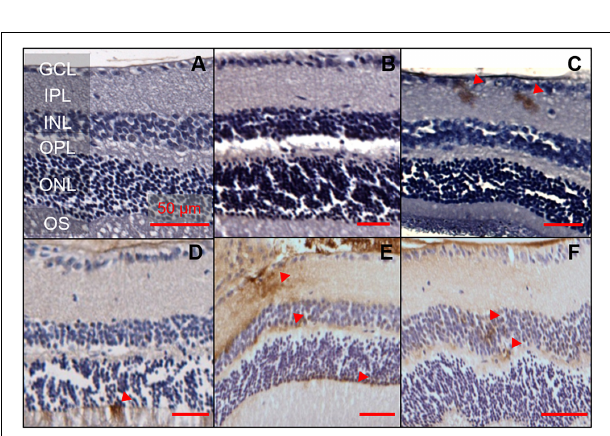
FIGURE 2 | A β was detectable in 5xFAD mice retinae at various ages. 1E8 labeled serial sections counterstained with haematoxylin showed A β immunoreactivity in the inner and outer retina of 5xFAD mice. 1E8 staining absent in (A) a 6-month-old WT mouse retina and (B) a negative control in a 6-month-old 5xFAD retina. 1E8 staining present in (C) a 6-month-old 5xFAD retina (D) a 12-month-old 5xFAD retina and (E,F) a 17-month-old 5xFAD retina. Positive A β staining was seen in the ganglion cell layer, inner plexiform layer, the inner and outer nuclear layers as marked by red arrows. Images feature tangential cuts to the retina which preclude meaningful thickness comparison. Scale bars, 50 µ m; GCL, ganglion cell layer; IPL, inner plexiform layer; INL, inner nuclear layer; OPL, outer plexiform layer; ONL, outer nuclear layer; OS, outer segments. Disclosure: separate histological sections from a subset of these animals have been displayed in another manuscript (Hadoux et al.,